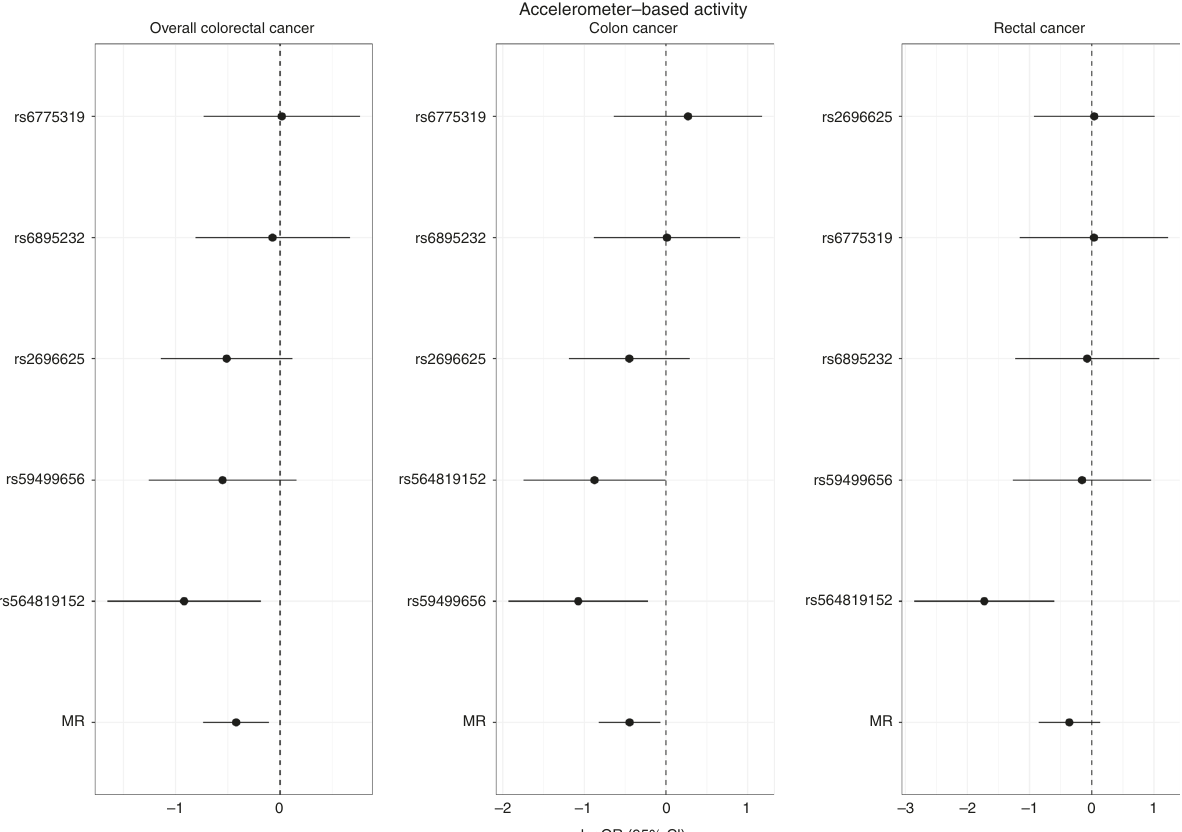
Fig. 2 Mendelian randomisation analysis for individual SNPs associated with accelerometer-measured physical activity in relation to colorectal cancer risk (overall, colon, rectal) using the genetic instrument from the GWAS by Doherty et al. 11 . The x axis corresponds to a log OR per one unit increase in the physical activity based on the average acceleration (milli-gravities). The Mendelian randomisation (MR) result corresponds to a random effects model due to heterogeneity across the genetic instruments. logOR = log odds ratio (black fi lled circle). 95% CI = 95% con fi dence interval (black line). SNP single nucleotide